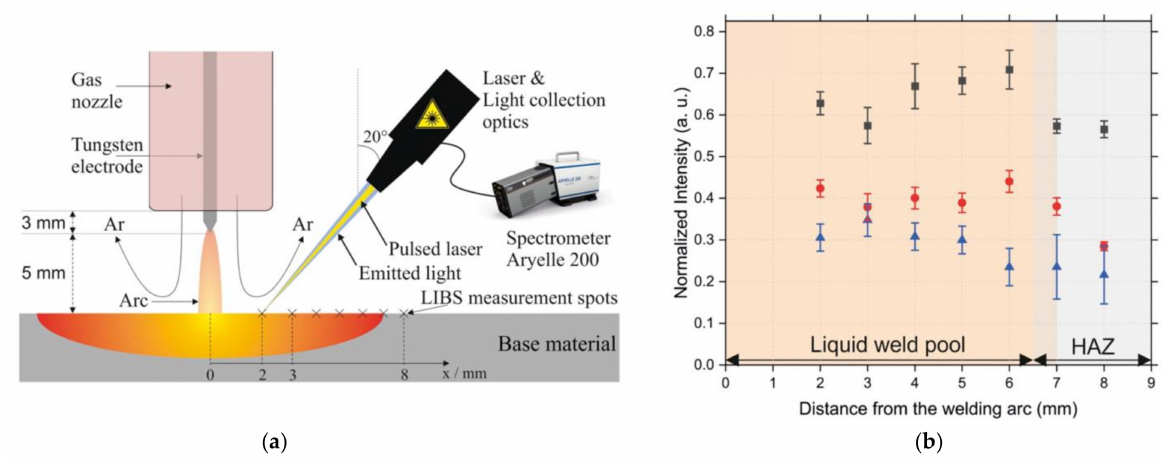
Figure 23. In-situ LIBS measurement of tungsten inert gas (TIG) stainless steel welding. ( a ) Experimental set-up of welding and LIBS equipment. ( b ) Intensities of Cr I/Fe I (black squares), Ni I/Fe I (red circles), and Mn I/Fe I (blue triangles) were measured at different distance to the welding arc (HAZ is heated affected zone). Adapted from